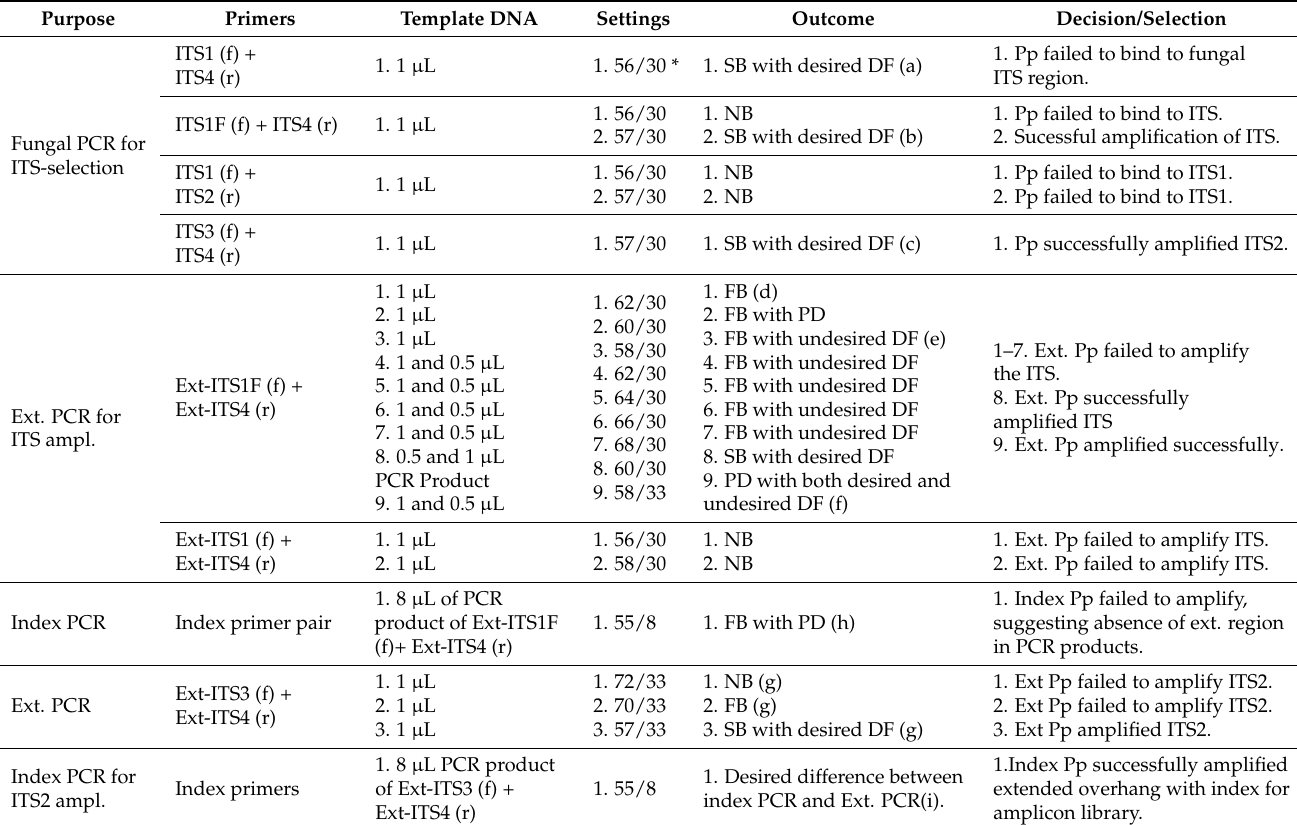
Table 2. An overview of the optimization procedure for preparation of aspen leaf metagenomics samples for HTS sequencing. Letters (a–i) refer to the resulting PCR gels as shown in Figure 3. Tem- plate DNA refer to volume of sample DNA extract. Settings = PCR settings indicated as “annealing temperature ◦ C”/“number of